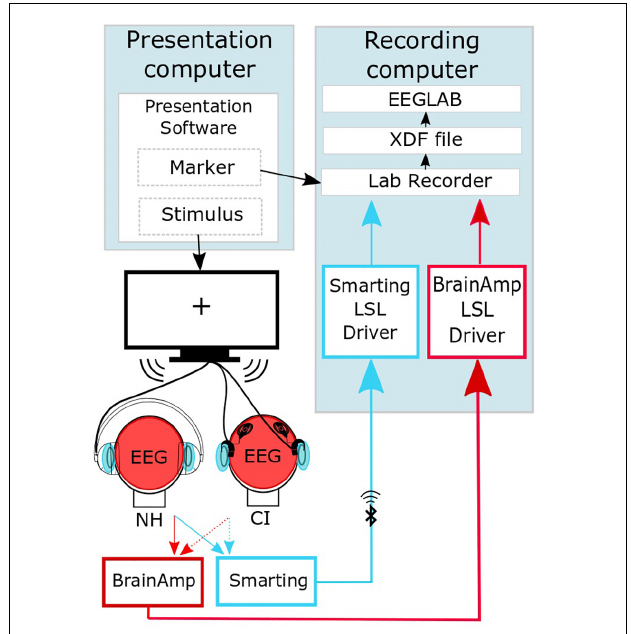
FIGURE 2 | Synchronized streaming of the two separate EEG systems (adapted from Mirkovic et al., 2016). The software Presentation (Neurobehavioral Systems, Inc., Berkeley, CA, United States) was used to present the sound to the participants and to send event markers to the Lab recorder software. EEG was recorded with one cEEGrid located around each ear (head, light blue) and a high-density cap (head, red). By means of the SMARTING mobile amplifier (mBrainTrain, Belgrade, Serbia), the cEEGrid signal was wirelessly sent to the recording computer, while the cap-EEG signals were recorded using the Brain Amp amplifiers (BrainProducts GmbH, Gilching, Germany) with a physical connection to the recording computer. EEG streams were joined into one output file in an extensible data format (.xdf). Further preprocessing of the EEG data was performed using the EEGLAB Toolbox (Delorme and Makeig,